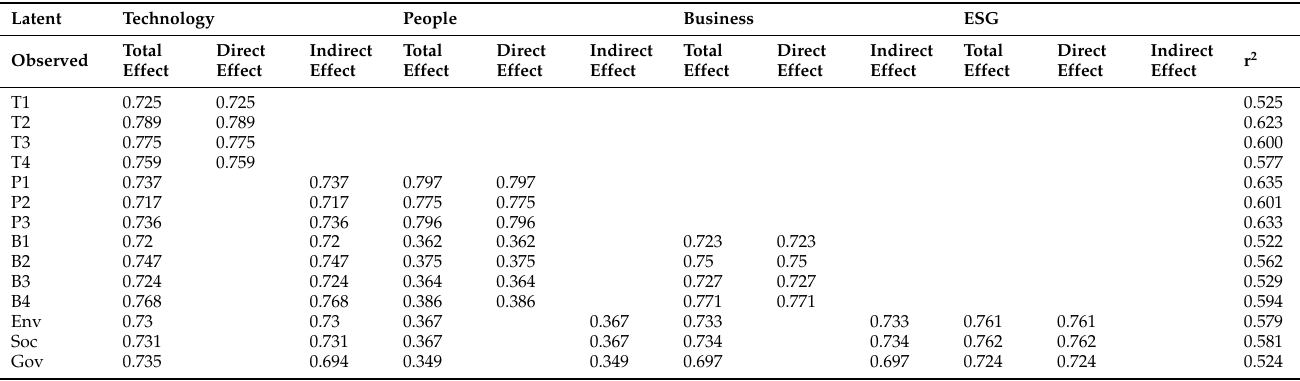
Table 9. The results of the path